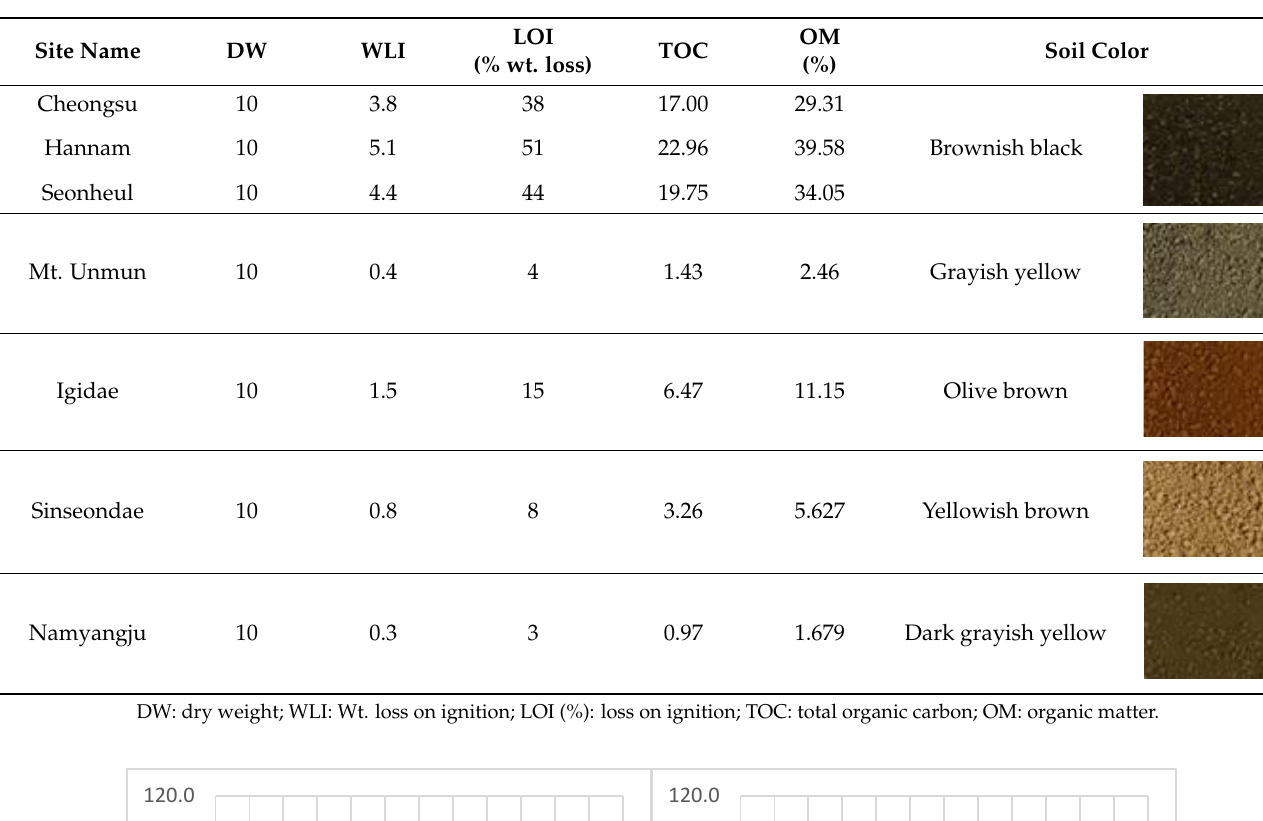
Table 4. Comparing organic matter and color of soil in the representative habitats of L. unmunsana.